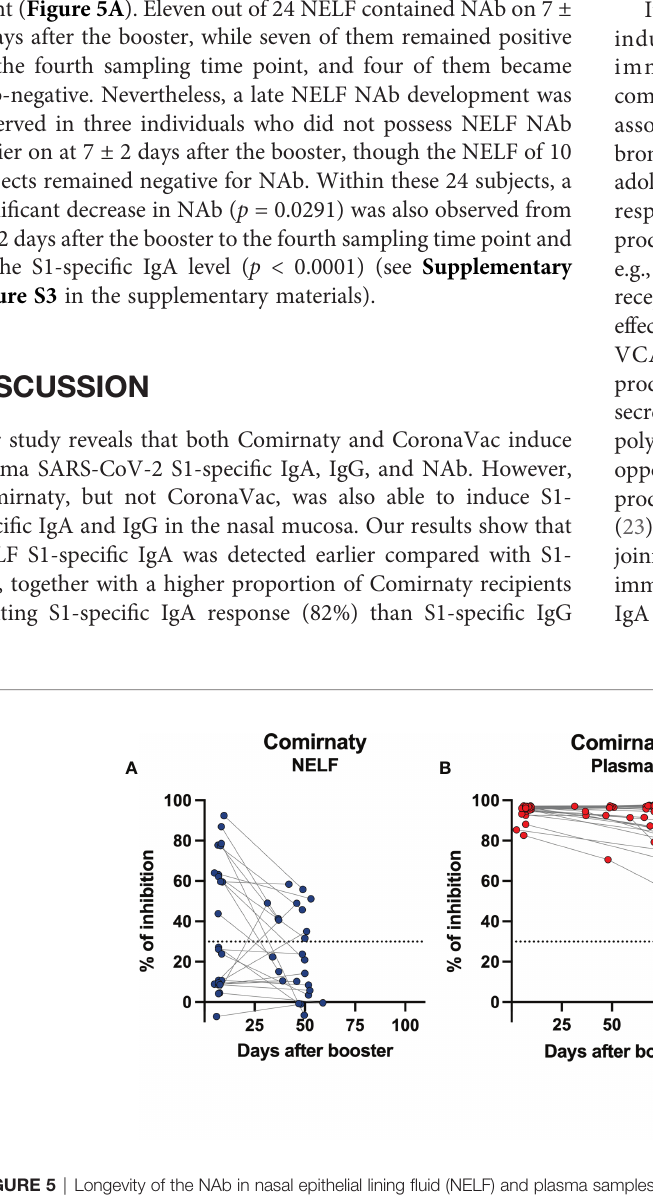
FIGURE 5 | Longevity of the NAb in nasal epithelial lining fl uid (NELF) and plasma samples. The paired percentage of signal inhibition in the (A) NELF and (B) plasma of 24 Comirnaty subjects and (C) plasma of CoronaVac recipients in the longitudinal group ( n = 12, red dots) and in the cross-sectional group ( n = 15) are shown. The data points of the same individual are joined by a dotted